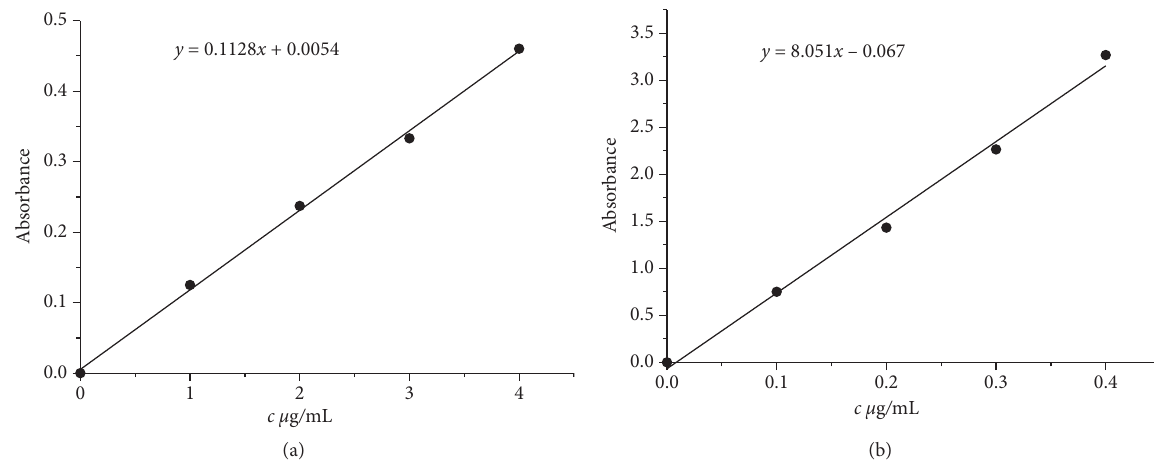
Figure 1: Standard curve of absorbance of (a) Si element and (b) Al